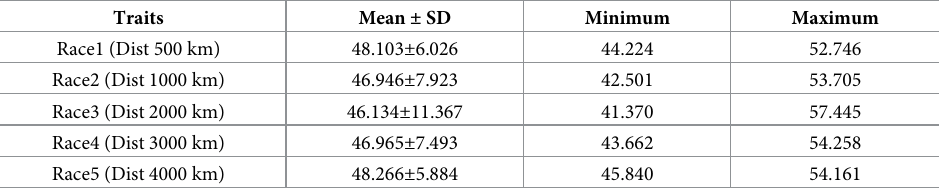
Table 3. Mean, minimum, and maximum deviations of DEBV for five racing traits of 127 racing pigeons.